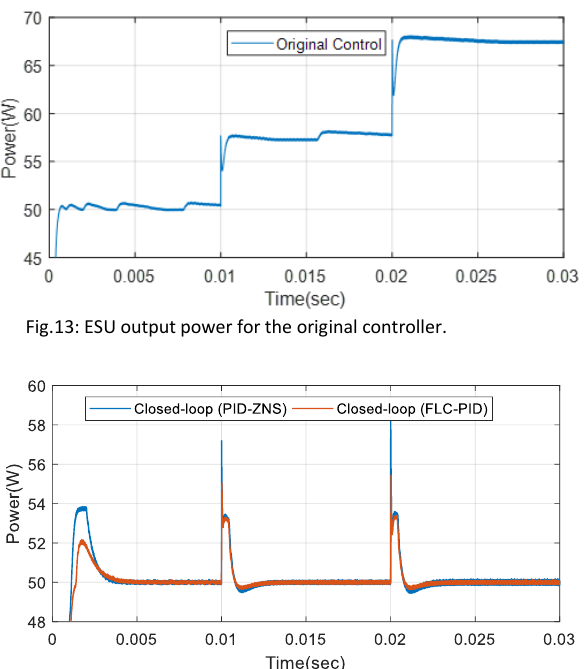
Fig.14: Output power for the proposed ESU with PID-ZNS and FLC- PID controller.